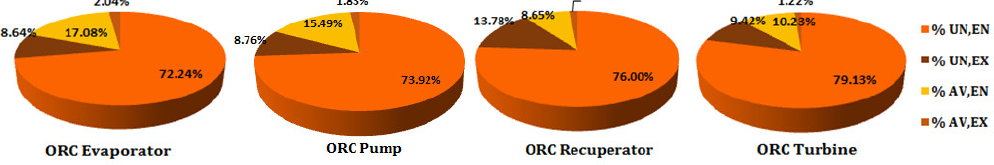
Figure 5. Advanced exergo-economic destruction rate of each component in the standalone geothermal cycle (GPP).